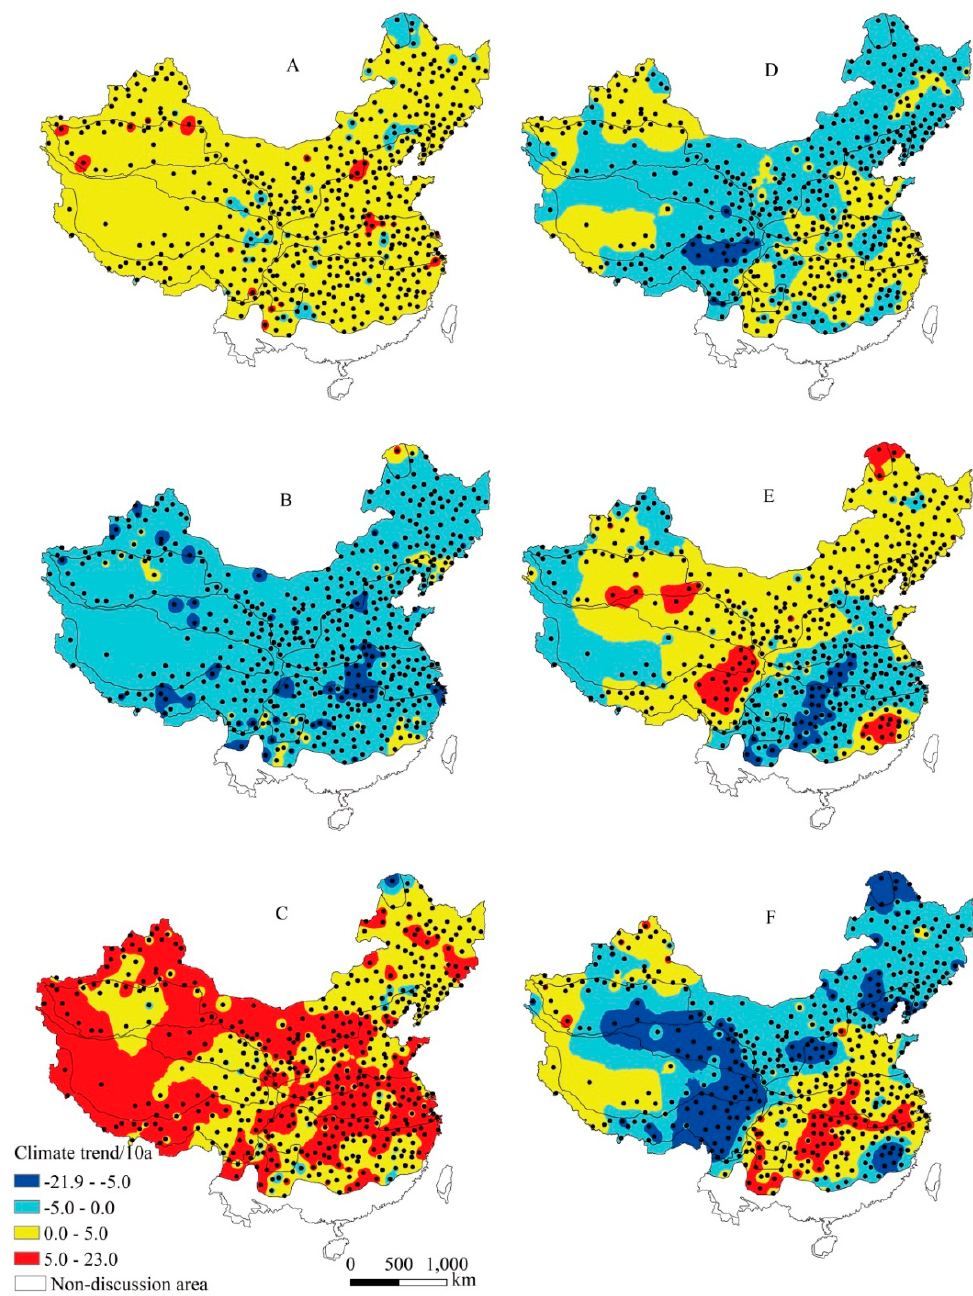
Figure 16. Climate trend of first frost day, last frost day, frost-free period from observed and gridded data. ( A – C ) is first frost day, last frost day and frost-free period respectively from observed data. ( D – F ) is that from gridded